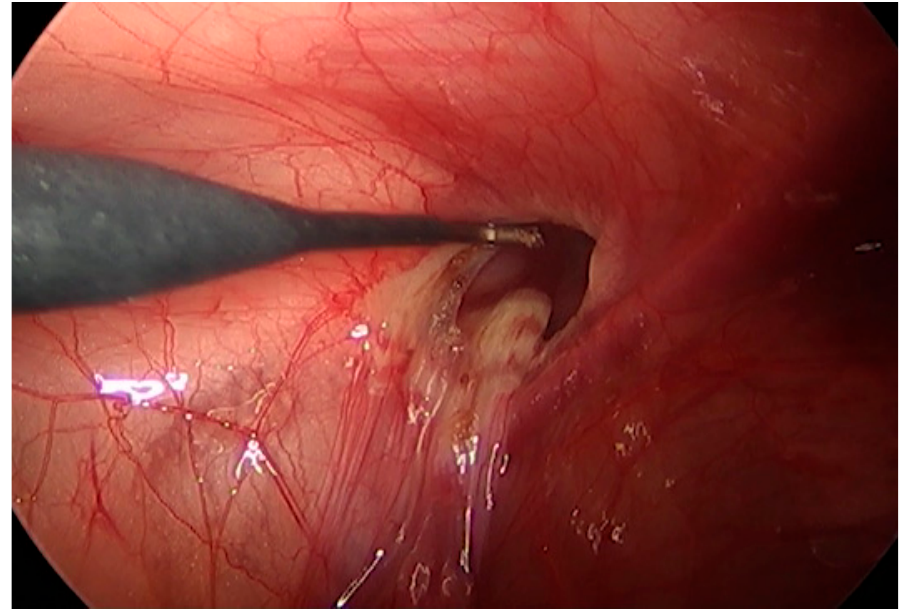
Figure 2. The mesothelial layer surrounding the internal ring was electrically cauterized.